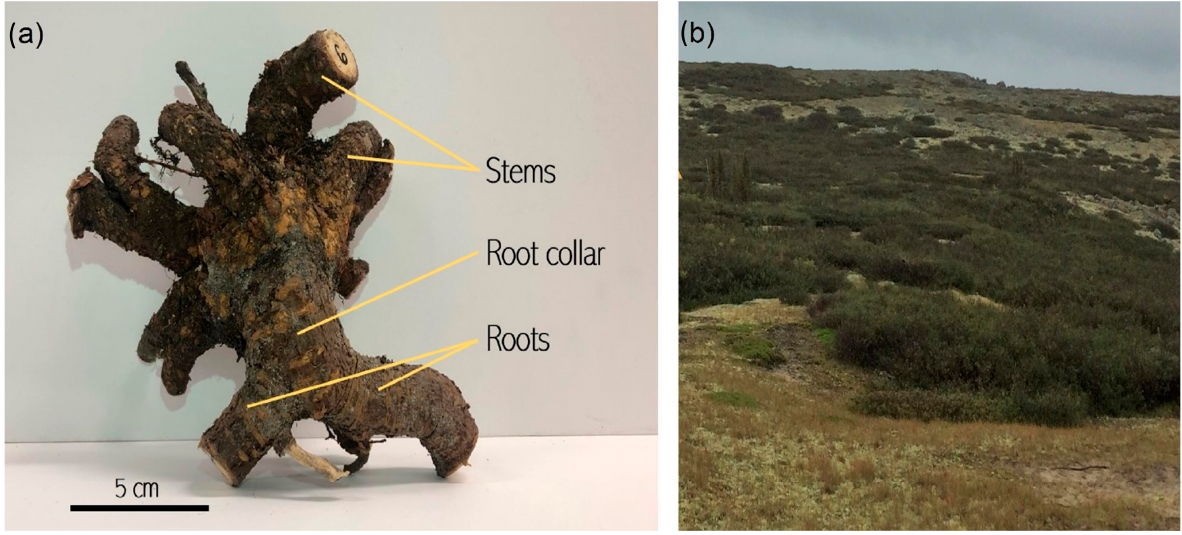
Figure 1. ( a ) Position of the root collar, roots, and stems of an uprooted Betula glandulosa individual. Stems and roots were cut and marked in the field to facilitate the transportation of the samples. ( b ) Landscape in the vicinity of the Boniface River research station, with patches of B. glandulosa interspersed in a matrix of tundra vegetation.